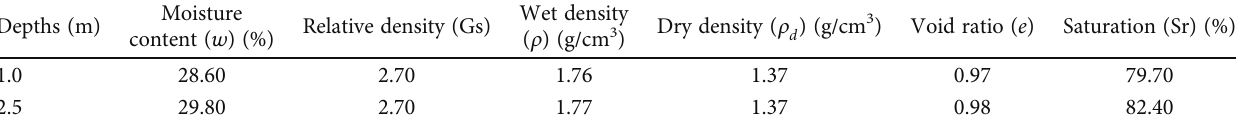
Table 1: Physical property test results of the laboratory